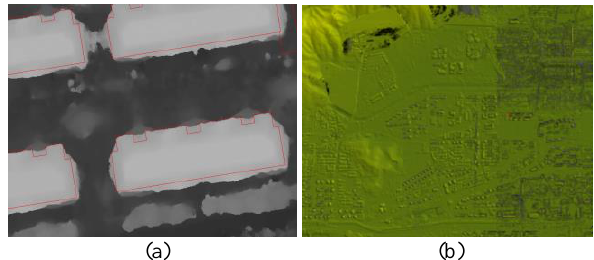
Figure 8. 3D scene model with non-oblique push-broom data. (a) Blur edges of buildings; (b) More DSM holes caused by lower